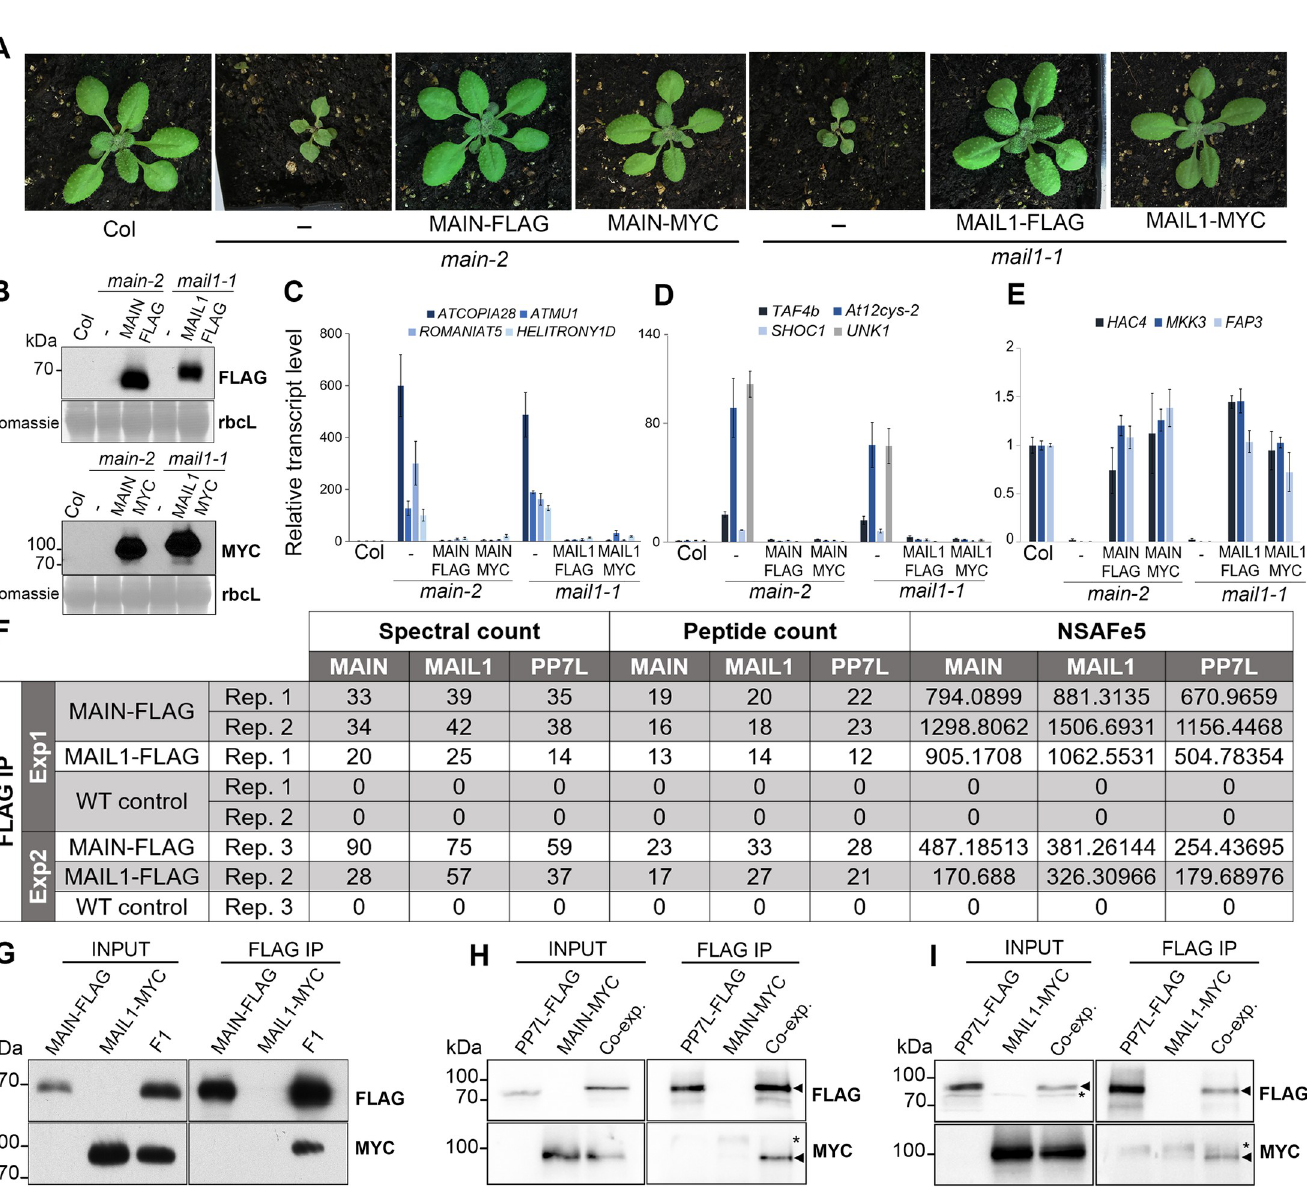
Fig 5. MAIN, MAIL1 and PP7L physically interact together. (A) Representative pictures of 3-week-old main-2 and mail1-1 mutants, and epitope-tagged complementing lines in comparison to WT Col plants. (B) Western blots using anti-FLAG and anti-MYC antibodies showing the accumulation of epitope-tagged PMD proteins at the expected sizes in the different complementing lines. Coomassie staining of the large Rubisco subunit (rbcL) is used as a loading control. KDa: kilodalton. (C-E) Relative expression analyses of upregulated TEs (C), upregulated genes (D) and downregulated genes (E) in the different complementing lines assayed by RT- qPCR. RT-qPCR analyses were normalized using the housekeeping RHIP1 gene, and transcript levels in the complementing lines and mutants are represented relative to WT Col. Error bars indicate standard deviation based on three independent biological replicates. (F) FLAG-tagged MAIN and MAIL1 proteins were immunoprecipitated and putative interacting proteins were identified by mass spectrometry. Numbers of identified spectra, peptides and the normalized spectral abundance factor (NSAFe5) are shown for two independent experiments, including three main-2 and two mail1-1 replicates. WT replicates are used as a negative control. Only proteins reproducibly enriched in all the FLAG-MAIN and FLAG-MAIL1 IP, and depleted in WT controls across multiple replicates are described in the table. (G) MAIL1-MYC was co-immunoprecipitated with MAIN-FLAG in F1 plants obtained by crossing MAIL1-MYC and MAIN-FLAG lines together. Parental MAIL1-MYC and MAIN-FLAG lines were used as negative controls. (H) The MAIN-MYC line was supertransformed with the PP7L-FLAG construct, and MAIN-MYC was co-immunoprecipitated with PP7L-FLAG. Plants expressing only MAIN-MYC or PP7L-FLAG were used as negative controls. (I) Same as H but